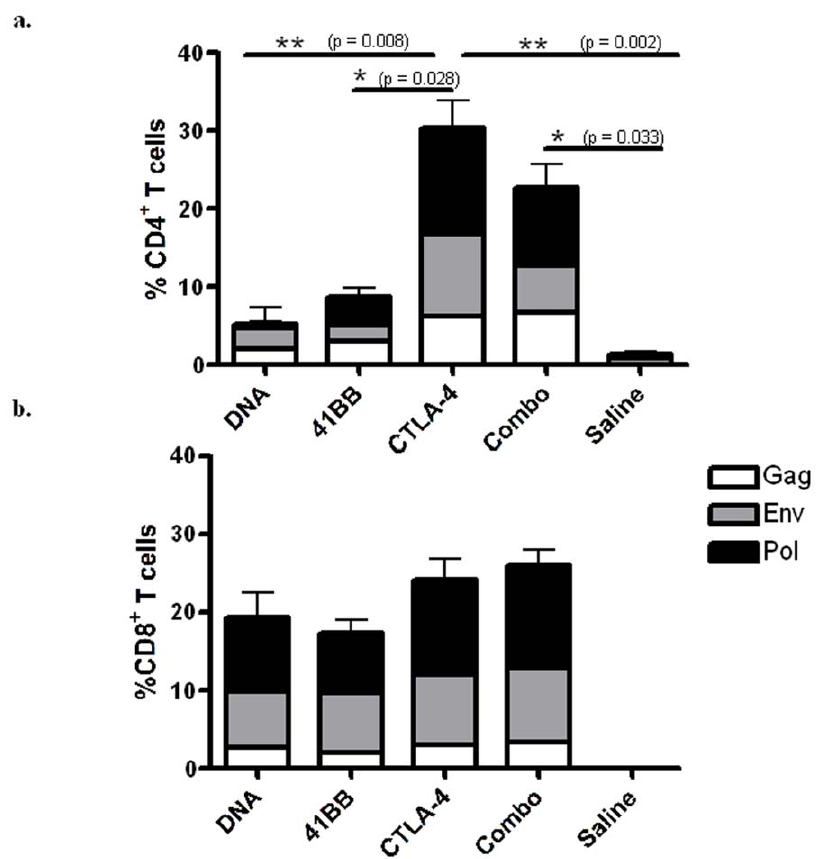
Figure 2. CTLA-4 blockade enhances the proliferative capacity of CD4 + and CD8 + T cells. Fresh PBMCs isolated after the second immunization were stained with CFSE and stimulated with SIVgag, env, and pol peptides in vitro for 5 days to determine the proliferative capacity of antigen-specific cells. The proliferative capacity of the CD4 + ( a ) and CD8 + ( b ) T cell compartments are shown as stacked group mean responses 6 SEM. Statistical differences between groups were determined by a one-way ANOVA with a Tukey post-hoc test.